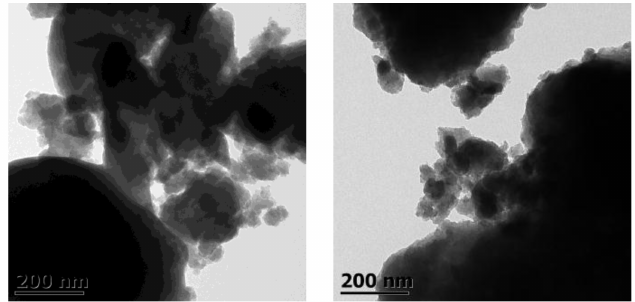
Figure 3. TEM images of the SiO 2 @TiO 2 powder sample (10 × ).